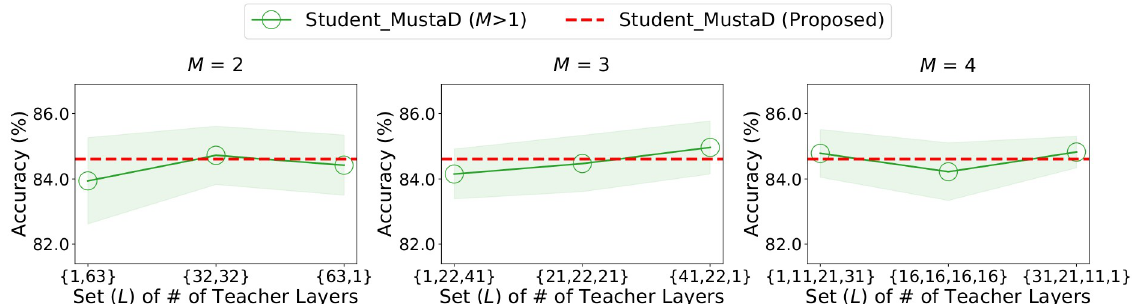
Fig 3. Accuracy of MustaD for different numbers of the effective layers in a student. M represents the number of effective layers in the student, and L corresponds to the set consisting of the number of teacher layers that each effective layer in the student imitates; e.g., M = 2 and L = {1, 63} denotes that the two effective layer in the student imitates a GCN layer, and 63 GCN layers of the teacher, respectively. Note that M USTA D, which has a single effective layer in the student, is enough to conserve the multi-hop feature aggregation of the teacher.